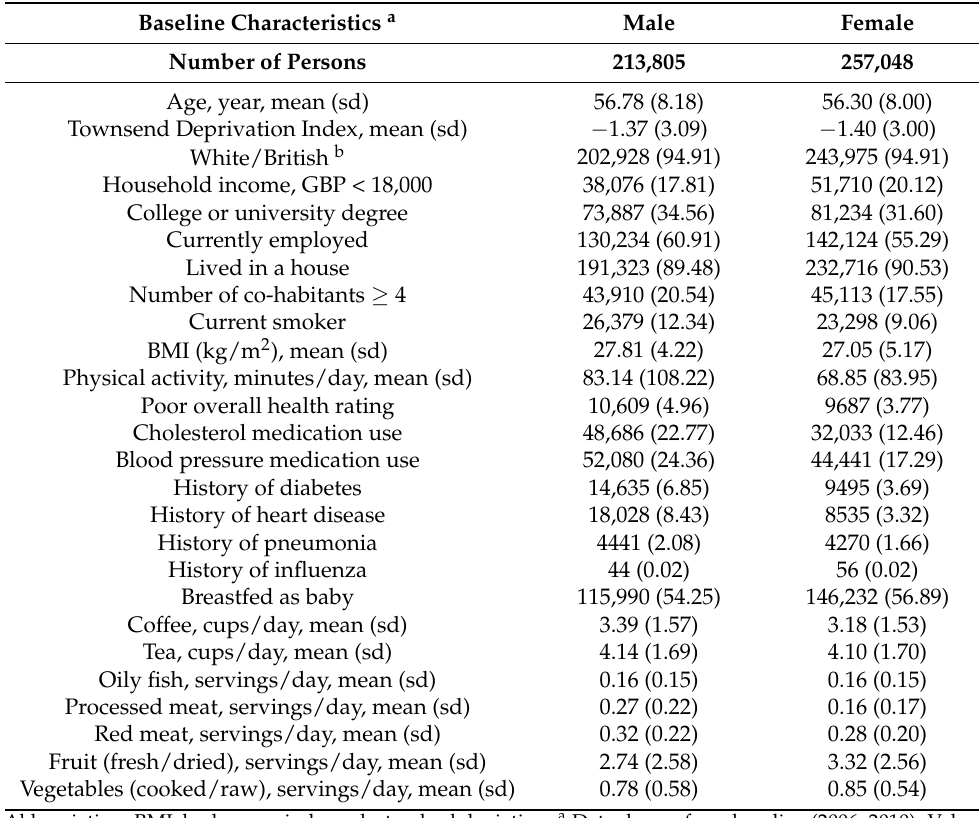
Table 1. Baseline characteristics of the UK